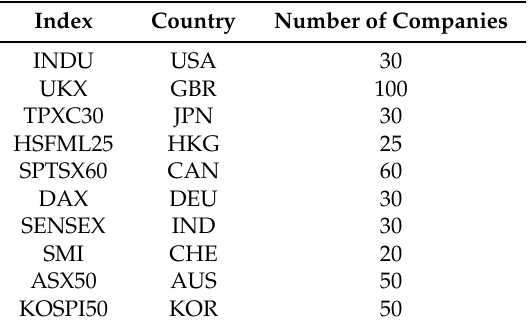
Table 1. Markets under